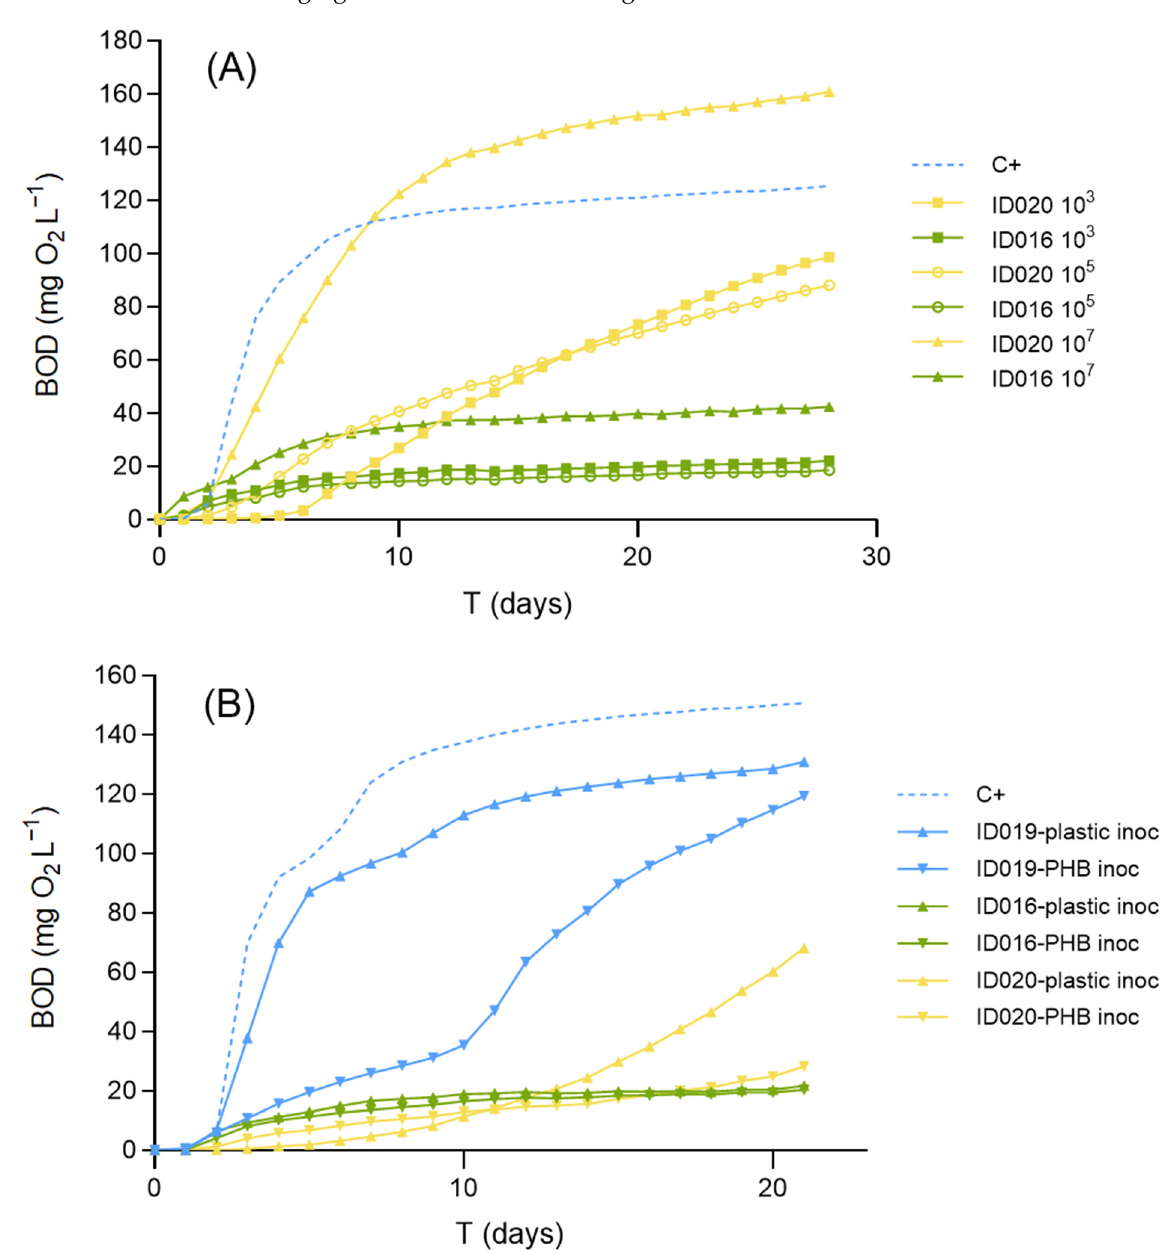
Figure 1. Effects of inoculum preconditioning ( A ) and pre-exposure ( B ). In ( A ), the performance